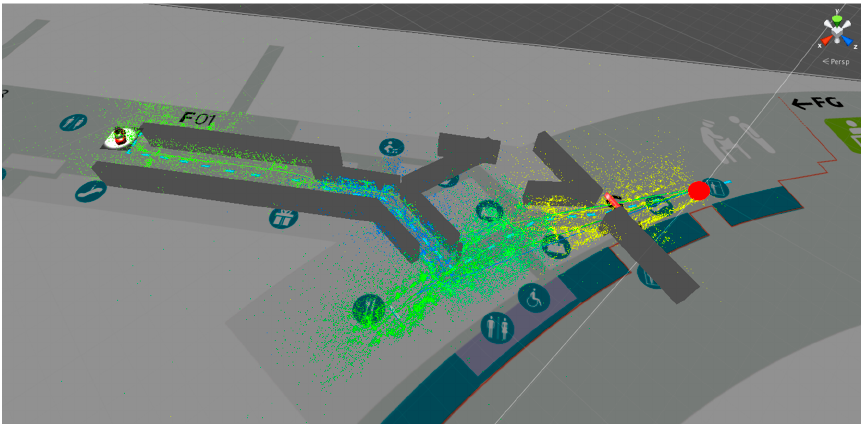
Figure 7. Screenshot of the content viewer.